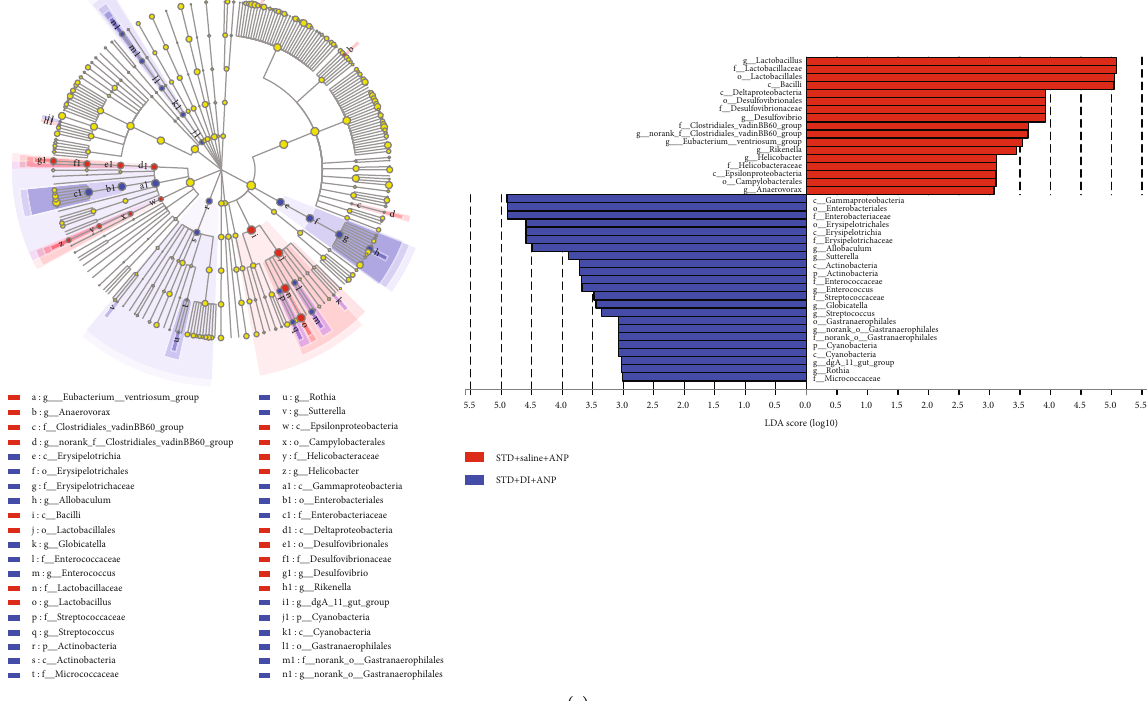
Figure 6: E ff ects of dithizone on microbiota composition in rats on standard diet followed by retrograde sodium taurocholate infusion. (a) Bacterial phyla and genera with signi fi cantly di ff erent abundance in rats treated with dithizone or saline. ∗ p < 0 : 05 , ∗∗ p < 0 : 01 , ∗∗∗ p < 0 : 001 , Wilcoxon test. (b) Heatmap showing correlation among SCFAs, lysozyme expression, intestinal barrier dysfunction, serum lipid, pathological changes, and gut micro fl ora. Blue indicates a negative correlation, while red indicates a positive correlation. ∗ p < 0 : 05 , ∗∗ p < 0 : 01 , ∗∗∗ p < 0 : 001 , Spearman test. (c) Analysis of linear discriminant analysis e ff ect size (LEfSe) using multilevel species hierarchy tree and LEfSe bars determined by linear discriminant analysis (LDA). n = 8 for each